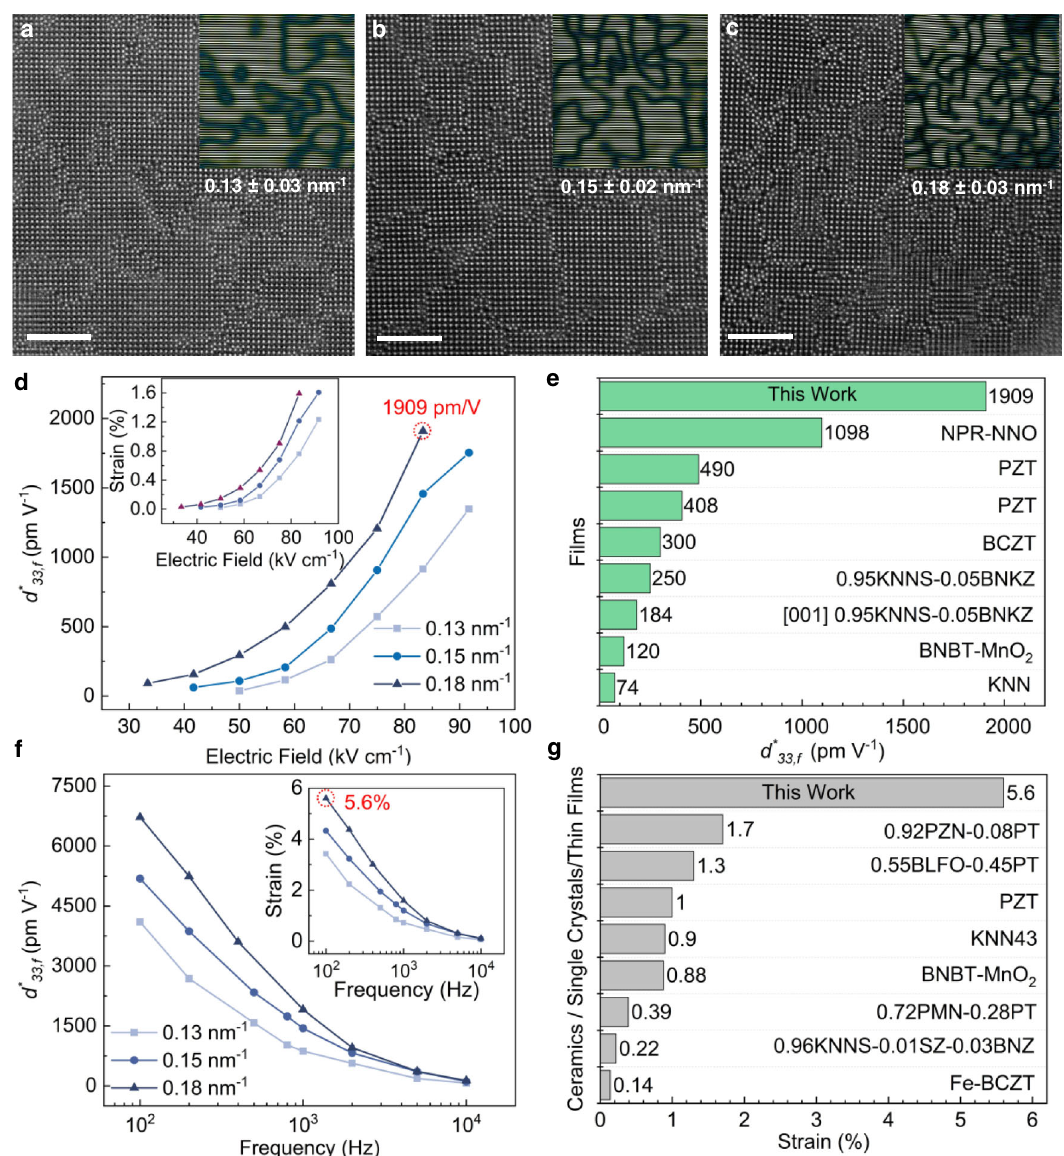
Fig. 1 Effect of planar fault density on the electromechanical response of the PF-KNN thin fi lm. Plan-view HAADF-STEM images of thin fi lms with the PF densities of a , 0.13 ± 0.03 nm − 1 b , 0.15 ± 0.02 nm − 1 and c , 0.18 ± 0.03 nm − 1 (scale bars equal 5 nm). d Variation of d * 33,f with the applied electric fi eld in fi lms having different PF densities measured at 1 kHz frequency (Inset shows the corresponding electric- fi eld-induced strain). e d * 33,f obtained in this work at 1 kHz frequency in the PF-KNN fi lm compared with those of previously reported lead-based and lead-free piezoelectric thin fi lms (Supplementary Table 1 for detailed comparison). f Variation of d * 33,f with the excitation frequency in fi lms having different PF densities at the applied fi eld of 83.3 kV cm − 1 (Inset shows the corresponding electric- fi eld-induced strain). g Electric- fi eld-induced strain obtained in this work compared with those of previously reported lead-based and lead-free piezoelectric single crystals, bulk ceramics, and thin fi lms (Supplementary Table 2 for detailed